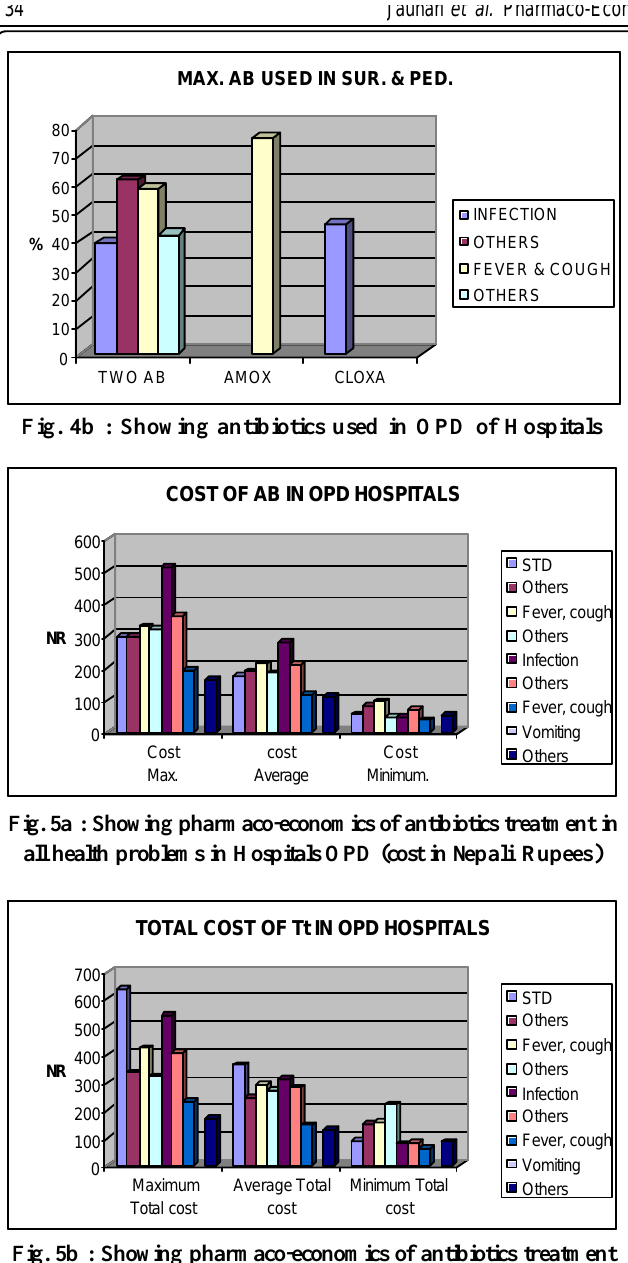
Fig. 5b : Showing pharmaco-economics of antibiotics treatment in all health problems in Hospitals OPD (cost in Nepali Rupees)